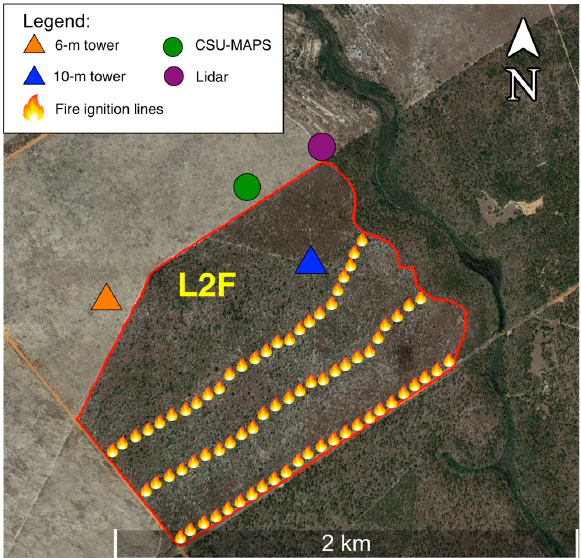
Figure 3. Meteorological measurement and ignition line locations during the L2F operational burn.